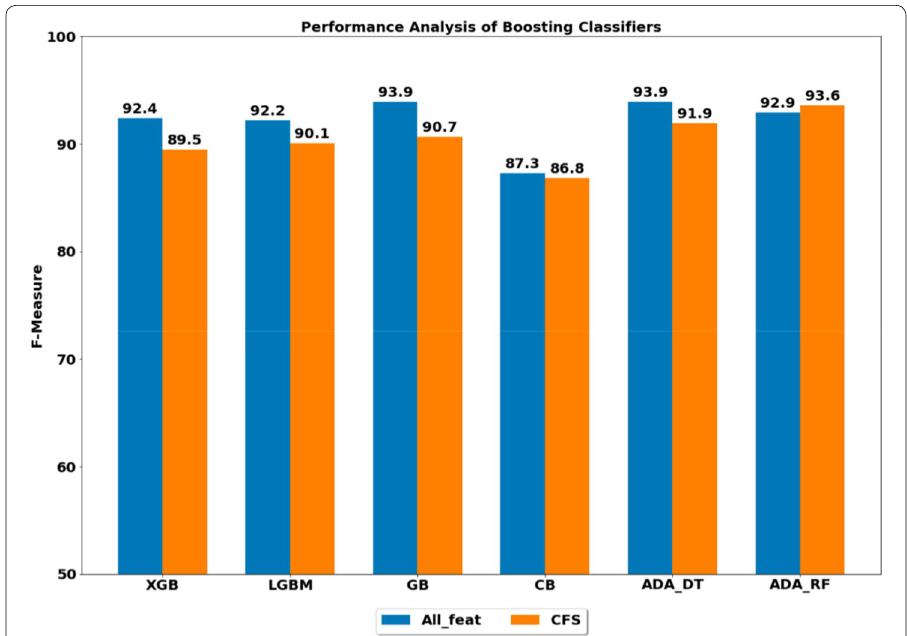
Fig. 3 Image from [25] showing relatively weak performance of CatBoost (CB) as compared to XGBoost (XGB), LightGBM (LGBM), Gradient Boosting(GB), AdaBoost using Decision Trees (ADA_DT) and AdaBoost using Random Forest